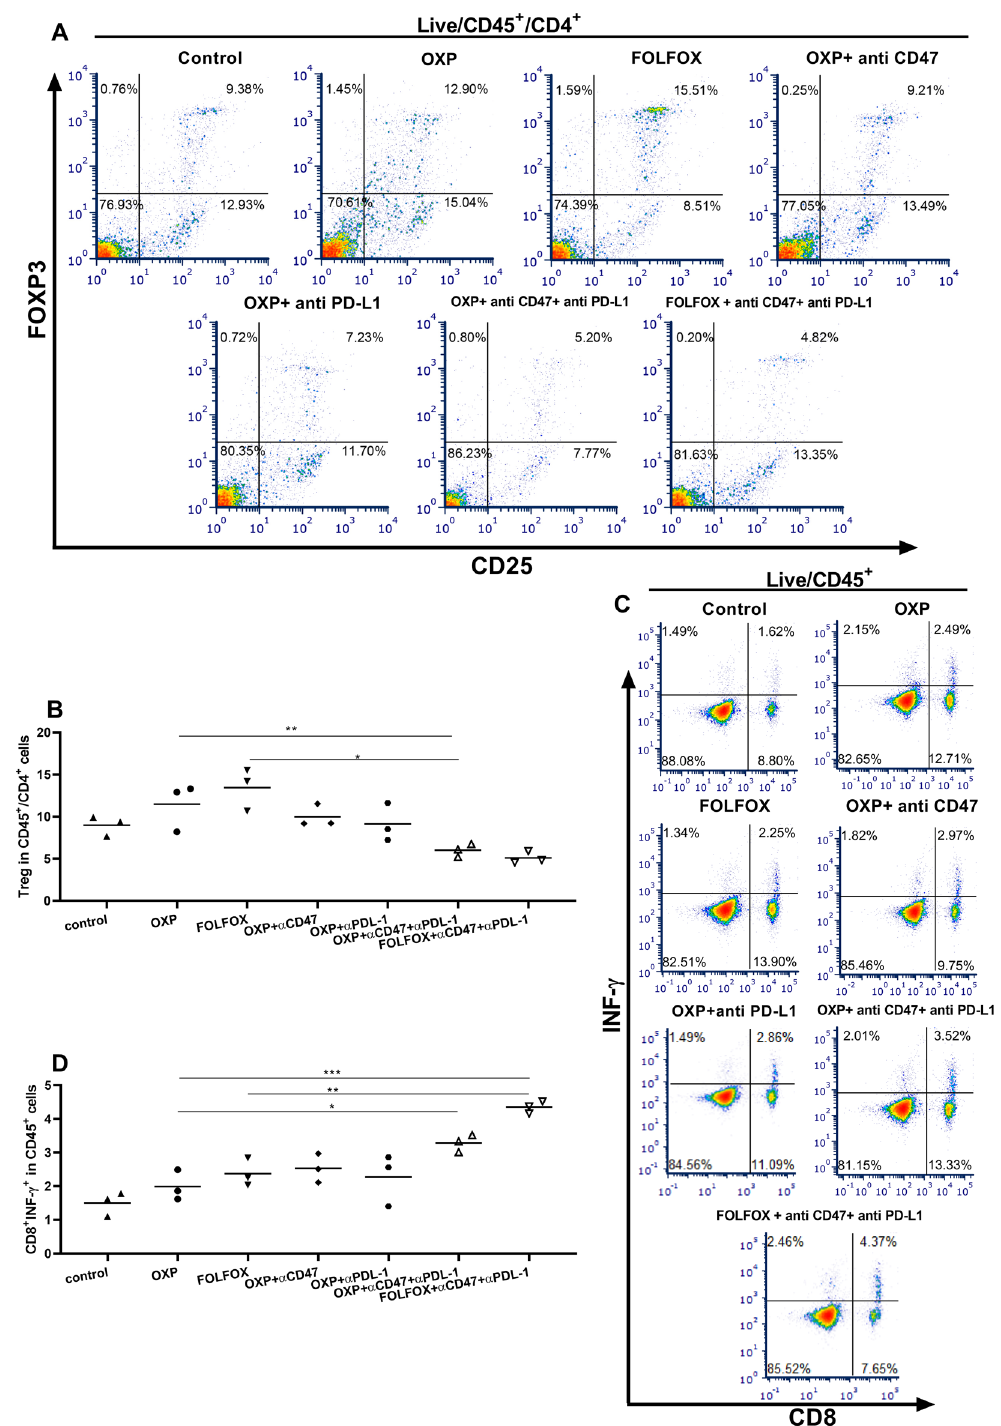
Figure 4. Combining therapy with OXP or FOLFOX with anti-CD47 and anti-PD-L1 deacreased the Treg in CD4 + cells and increased CD8 + /INF-γ + cells in CD45 + population in spleen. ( A ) Gating strategy used for Treg analysis in spleen. ( B ) OXP and FOLFOX increased Treg in CD4 + cells, however this increase wasn’t significant. Both OXP or FOLFOX combined with anti-CD47 and anti-PD-L1 decreased the Treg in CD4 + cells, and this decrease was significant compared with mice receiving OXP or FOLFOX regimen alone. ( C ) Gating strategy used for CD8 + /INF-γ + analysis in CD 45 + population of spleen. ( D ) Both OXP or FOLFOX combined with anti-CD47 and anti-PD-L1 increased CD8 + /INF-γ + in CD45 + population. This increase was significant in compared with most of other therapeutic